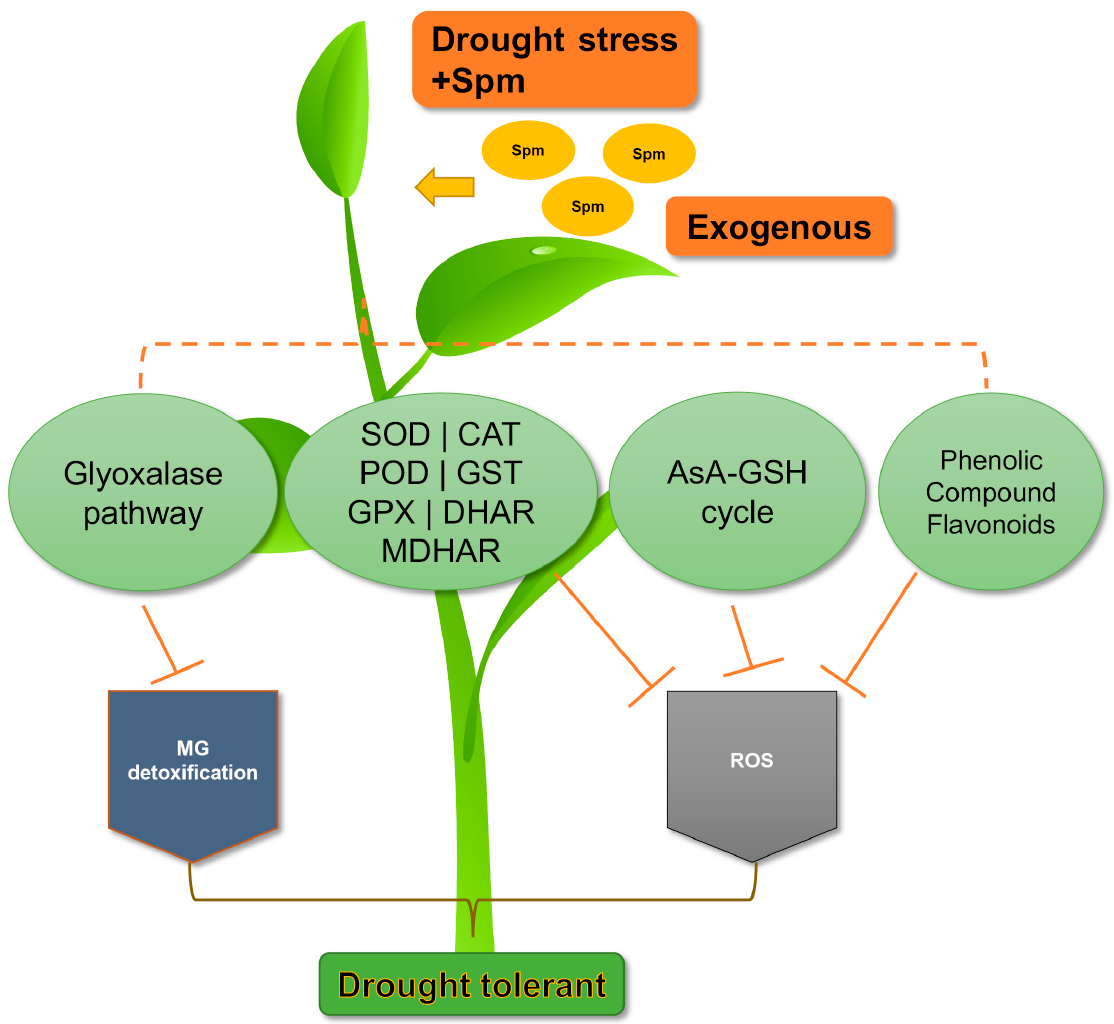
Figure 3. Spermine (Spm)-induced antioxidant defense and glyoxalase system reduces drought stress in plants. The glyoxalase pathway suppresses methylglyoxal (MG) toxicity. Likewise, the antioxidant enzymes, e.g., superoxide dismutase, SOD; catalase, CAT; peroxidase, POD; glutathione S-transferase, GST; glutathione peroxidase, GPX; dehydroascorbate reductase, DHAR, and monodehydroascorbate reductase, MDHAR, and the non-enzymatic compounds, e.g., phenols and flavonoids, ascorbate, AsA, and glutathione suppress the accumulation of ROS.